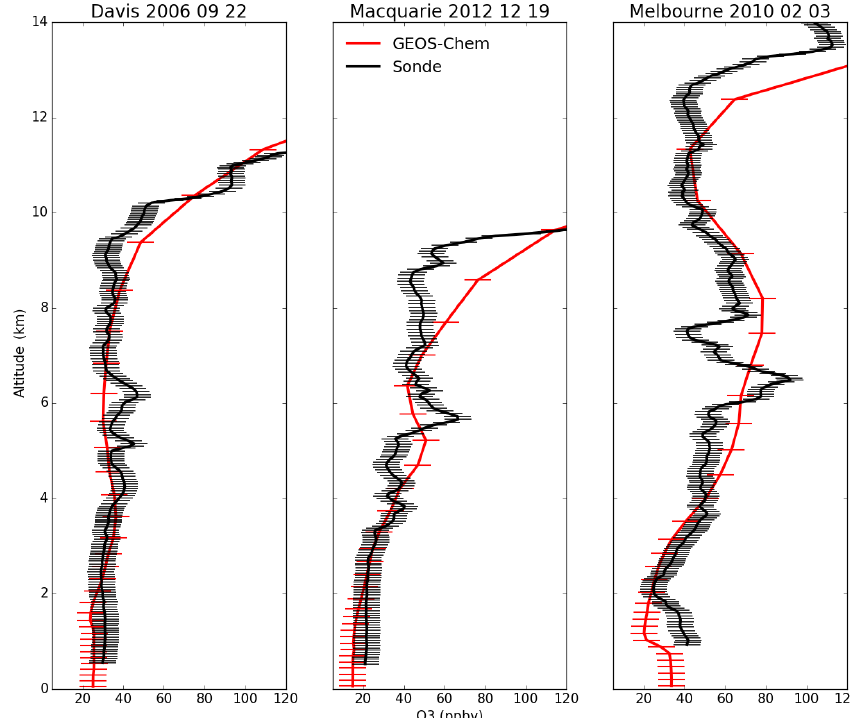
Figure 11. Example comparisons of ozone profiles from ozonesondes (black) and GEOS-Chem (red) from three different dates during which STT events were detected from the measurements. The dates were picked based on subjective visual analysis. The examples show the best match between model and observations for each site. GEOS-Chem and ozonesonde pressure levels are marked with red and black dashes